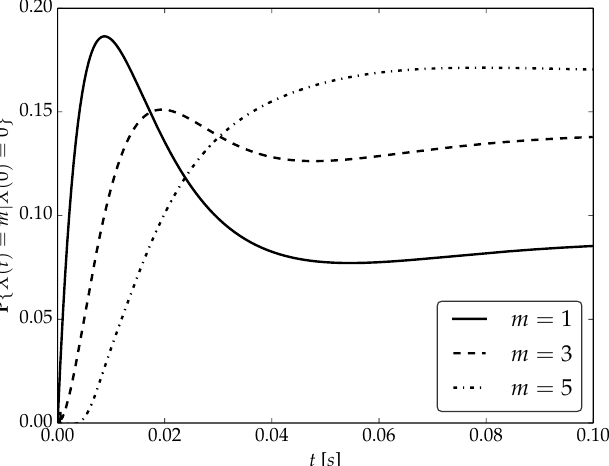
for P 2 , ρ = 1 and mean setup time X ( t ) = m X ( 0 ) = 0 { | }